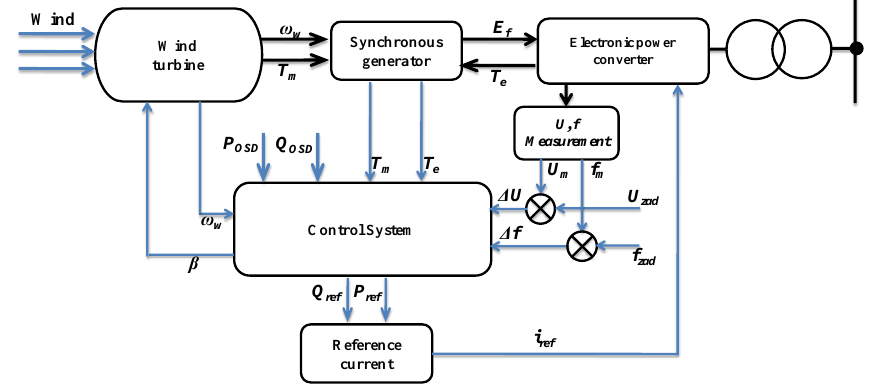
Figure 2. A block diagram of the reference turbine-generator unit model.